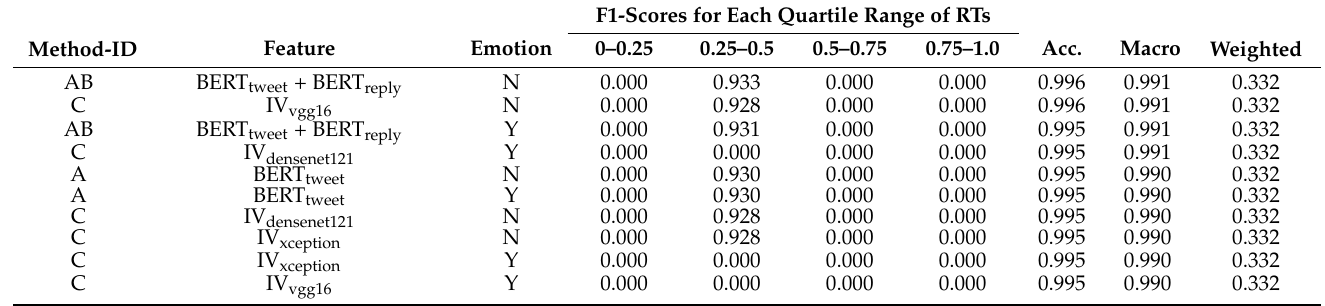
Table 5. Top 10 F1-scores and accuracies of RT prediction (proposed methods).